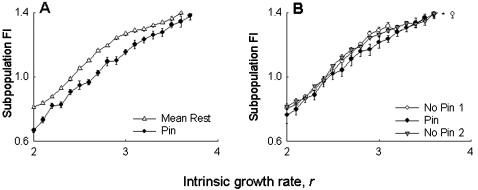
Simulations mimicking experiment: effect of pinning at the subpopulation level. (A) The FI of the pinned subpopulation was lower than the mean of the remaining eight subpopulations, over a substantial range of the intrinsic growth rate parameter, r. (B) There was no difference in the average FI of the pinned group and its two neighboring groups. These observations agree with the experimental results (cf. Fig 1), implying that the experimental findings are non-Drosophila specific. All data points in this, and subsequent simulation figures, represent average of 10 independent runs. See text for details of simulations.